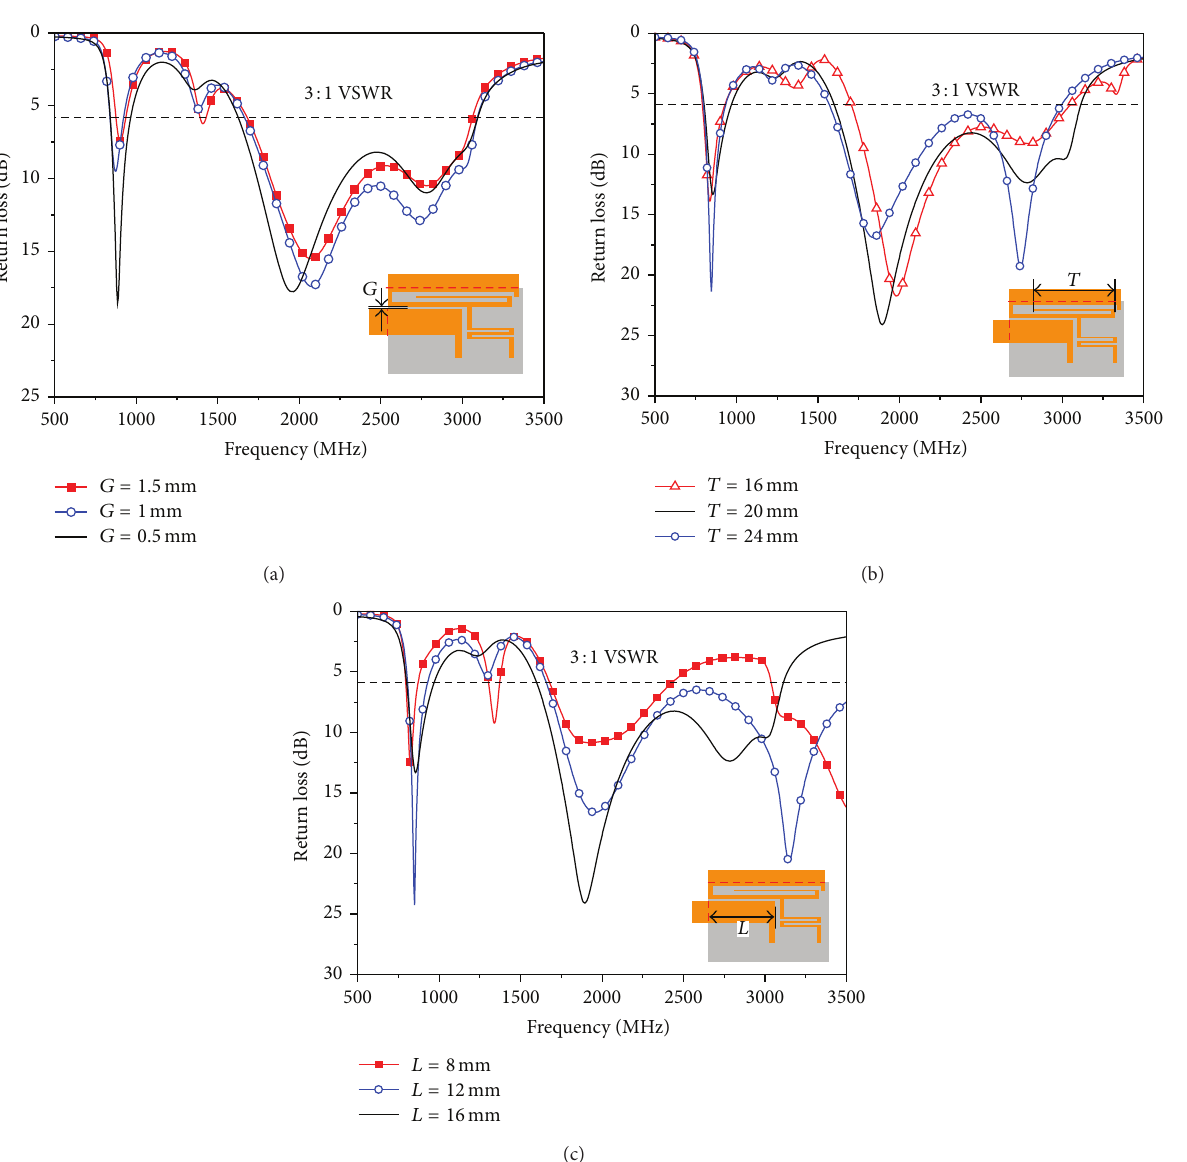
Figure 3: Simulated return loss as a function of (a) the coupling gap width 𝐺 between the feeding strip and the shorting strip branch 1, (b) the length 𝑇 of the end of the shorting strip branch 2, and (c) the length 𝐿 of the feeding